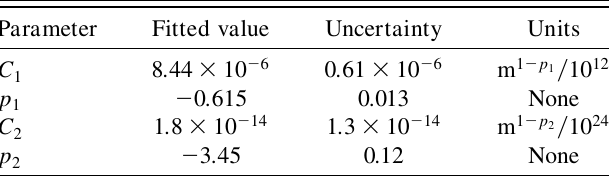
TABLE I. Results from fits to our simulation for linear and quadratic parametrizations.